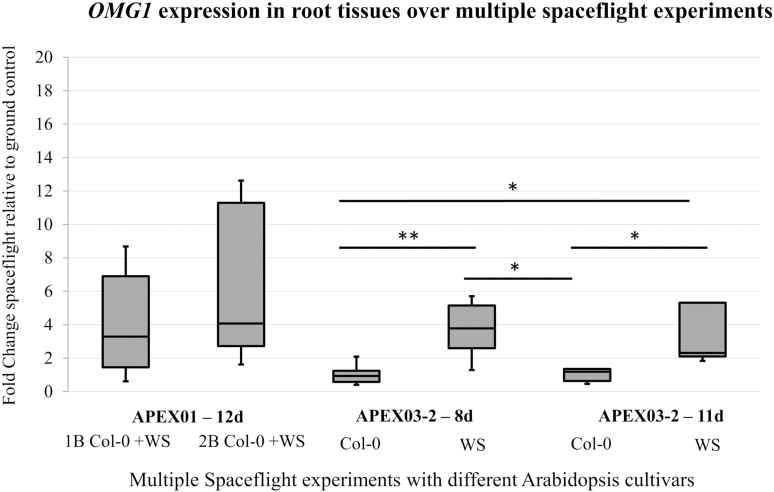
OMG1 transcripts are up-regulated in WS but unchanged in Col-0 consistently over multiple spaceflight experiments. Ecotypes WS or Col-0 were grown onboard the ISS for the number of days (d) indicated, harvested and compared to comparable ground controls. OMG1 transcripts for flight and ground control samples assayed with qRT-PCR. Spaceflight experiment APEX01-2B launched to the ISS via STS131 and analyses published in Paul et al. (2013b). The same RNA used in the 12d APEX01 microarrays was used for qRT-PCR shown here. Spaceflight experiment APEX01-1B launched to the ISS via STS129, and spaceflight experiment APEX03-2, 8 day and 11 day was launched to the ISS via SpaceX05. Boxplots were constructed from nine replicates for each sample. Expressions were normalized to UBQ11 and plotted spaceflight relative to ground control using results generated from TaqMan™ qRT-PCR. Spaceflight experiments show that OMG1 transcript is up-regulated in spaceflight relative to ground controls in WS plants, whereas in Col-0 it remains largely unchanged. Significance *(P < 0.01), ** (P < 0.001) between samples is calculated by doing a single-factor ANOVA followed by post hoc Student’s t-test with Bonferroni correction.